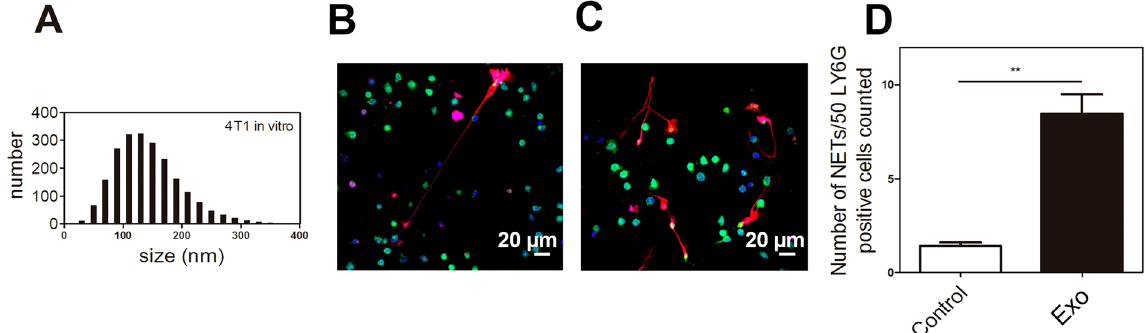
Figure 4. Tumor-derived exosomes induce NET formation. ( A ) Histogram indicating the size distribution of exosomes isolated from the culture supernatants of 4T1 cells. Exosomes were isolated and quantified as described in the Methods section. Bone marrow cells isolated from G-CSF-treated mice were incubated for 3 h at 37 °C in the absence ( B ) or presence ( C ) of 0.1 µ g of 4T1-derived exosomes (Exo). Immunofluorescence staining for DNA (blue), Ly6G (green) and citrullinated histone (red) was performed as described in the Methods section. Scale bars = 20 μ m. ( D ) The quantification of NETs was performed as described in the